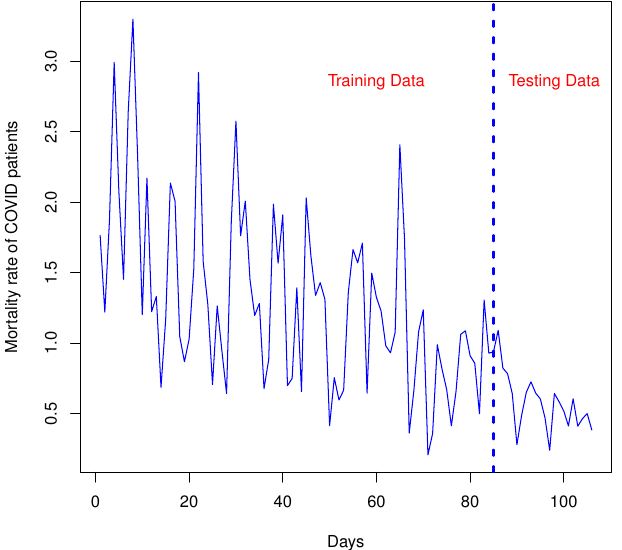
Figure 8. Divison of mortality rate of the COVID-19 patients data taken from